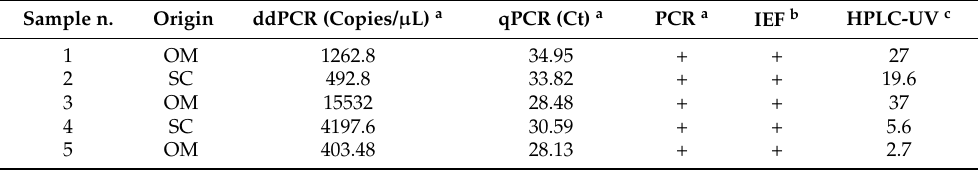
Table 2. ddPCR, qPCR, IEF, and HPLC-UV of buffalo mozzarella cheese samples. Sample